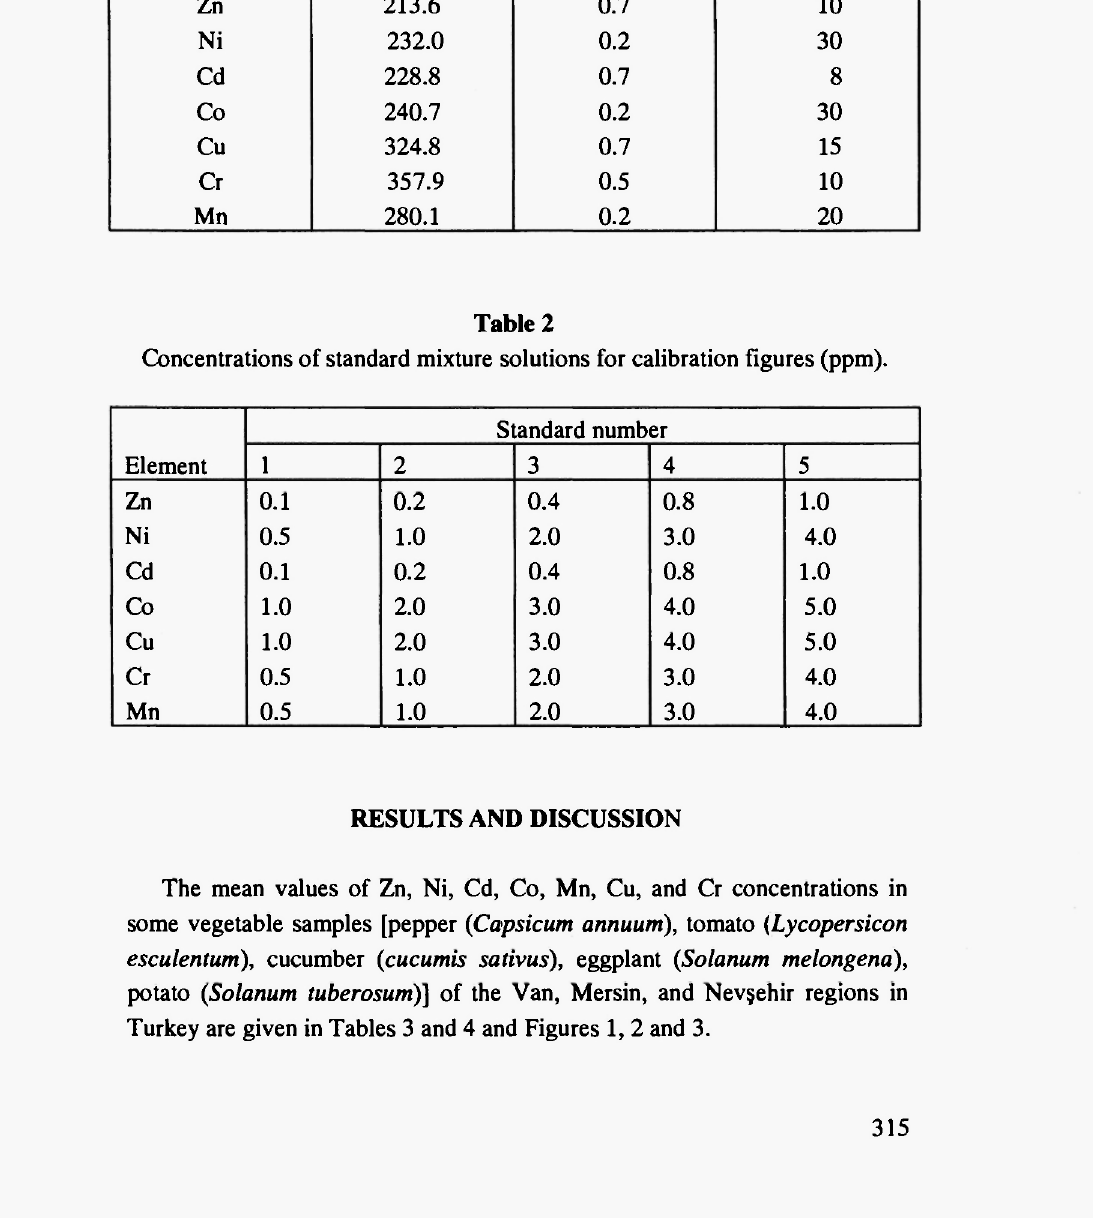
Operating conditions for flame atomic absorption spectrometry.